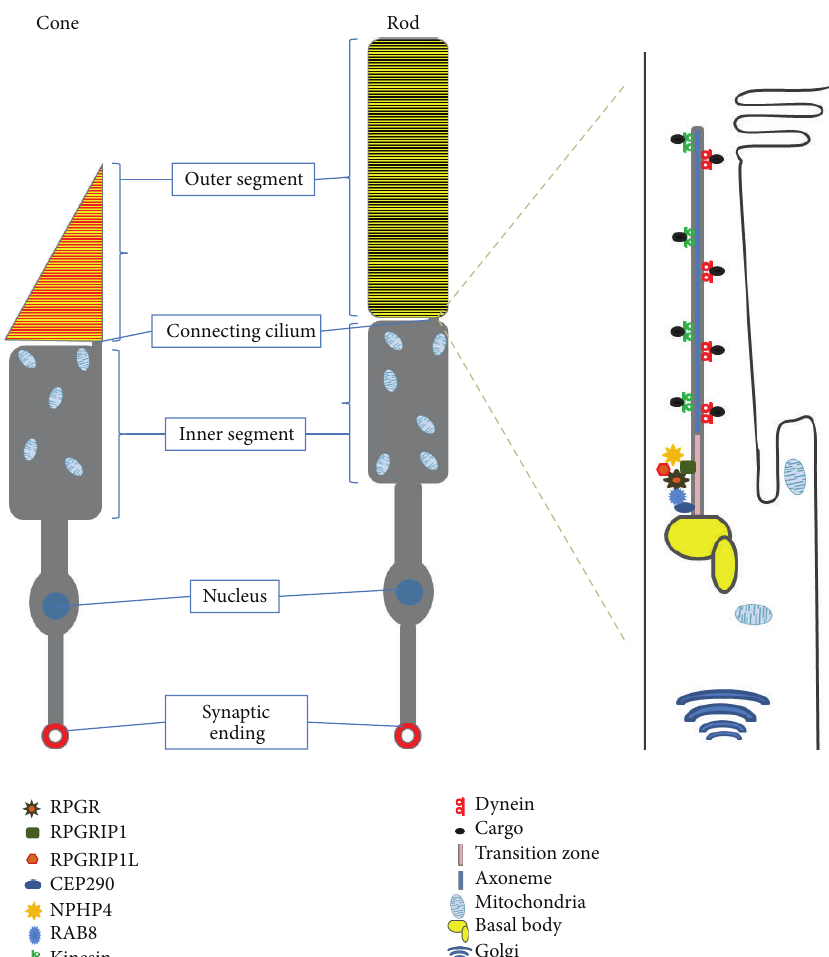
Figure 1: The photoreceptor primary cilia. The distinct compartments of both rod and cone cells (left side). Protein trafficking in photoreceptor connecting cilium through intraflagellar transport (IFT) is carried out by motor proteins, kinesin and dynein (right side). CEP290, centrosomal protein 290 kDa; NPHP4, nephronophthisis 4; RPGR, retinitis pigmentosa GTPase regulator; RPGRIP1, RPGR interacting protein 1; RPGRIP1L, RPGR interacting protein 1-like (right